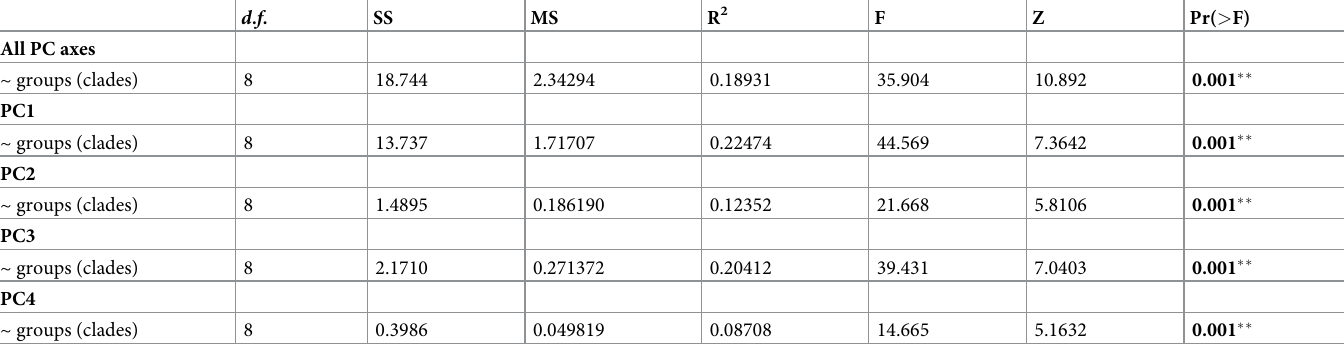
Table 1. Nonparametric analysis of variance based on RRPP for N = 1,239. Coefficient estimation via OLS. Type I (sequential) sums of squares were used to calculate the sums of squares and cross-products matrices. Effect sizes (Z) are based on the F distribution. d . f .